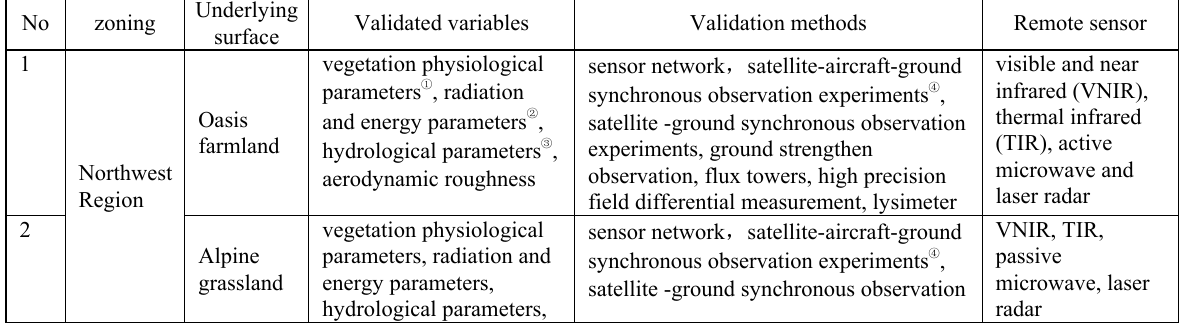
Figure 2. Core sites and their vegetation types of VRPC Table 1. Core observation sites and their functions of VRPC during the first